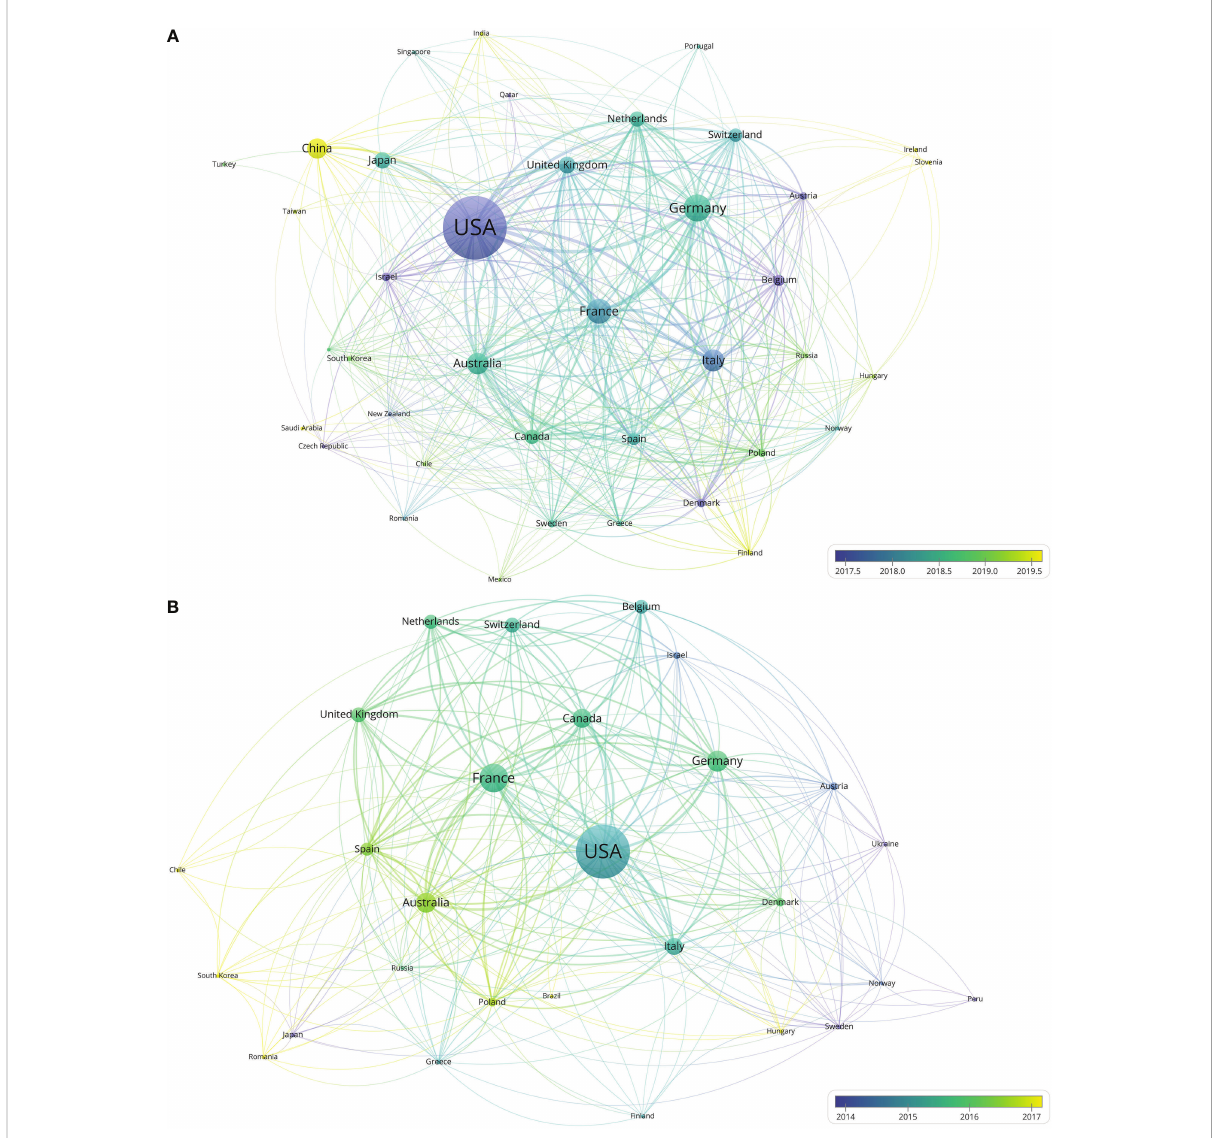
FIGURE 4 (A) Network visualization of countries with at least fi ve papers related to melanoma immunotherapy. (B) Network visualization of countries with top-papers related to melanoma immunotherapy. The circle size represents the number of papers. The breadth of the curves represents the connection